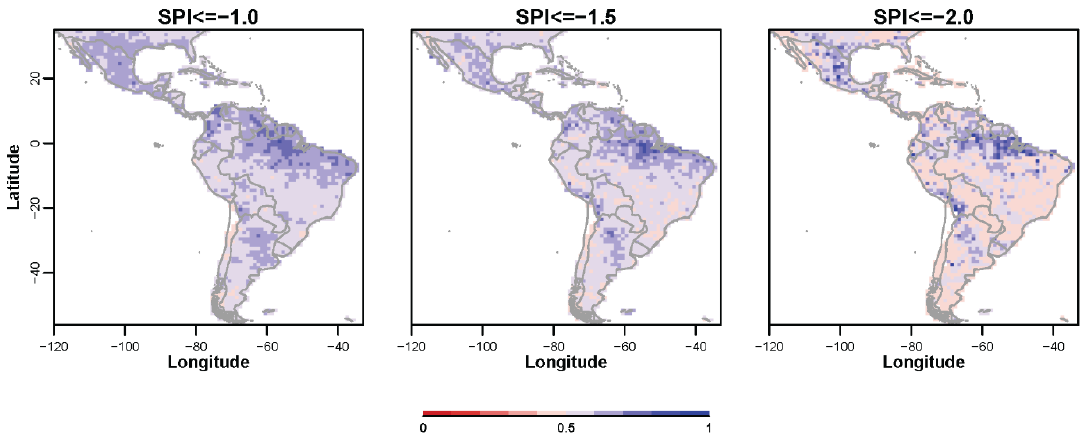
Figure 8. Area under the Relative Operating Characteristic (ROC) curve for the probability of drought detection at different SPI3 frequencies. Values indicated in the color bar are estimated at lead time of 3 months for the hindcast period 1981–2010.